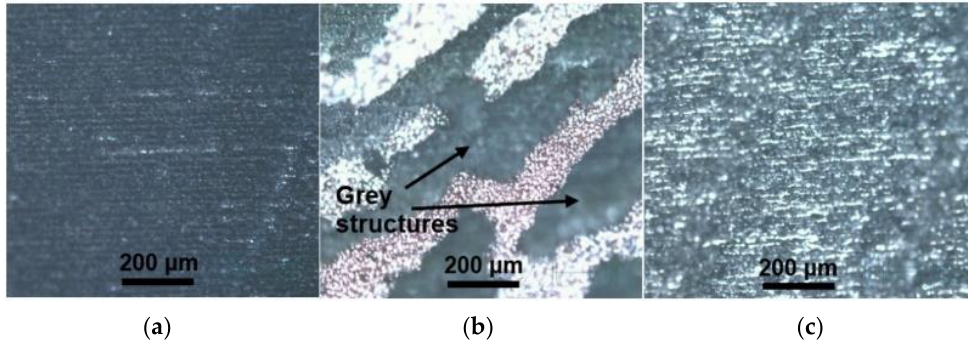
Figure 6. Microscope images of the sample surface: ( a ) treated at the focal plane. Soot appeared on the surface of the sample; ( b ) treated 4 mm below the focal plane, where clusters of gray-colored structures formed; ( c ) treated 7 mm below the focal plane. LIG structures, with smooth surface and low sheet resistance, were formed in this regime.